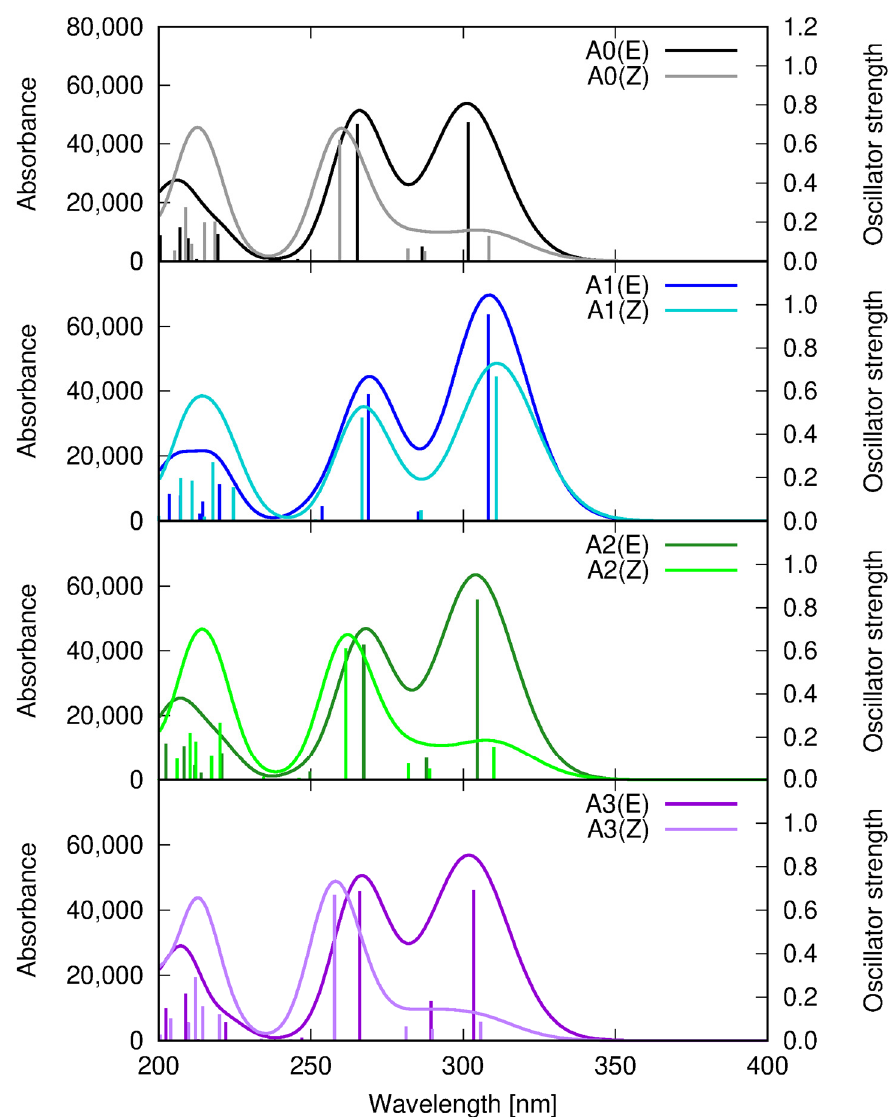
Figure 7. Absorption spectrum for A0–A3 isomers, calculated within the ω B97X-D/def2-SVP ap- proach in vacuum. Dark lines correspond to the more stable E isomers, and light lines—to the less stable Z isomers.